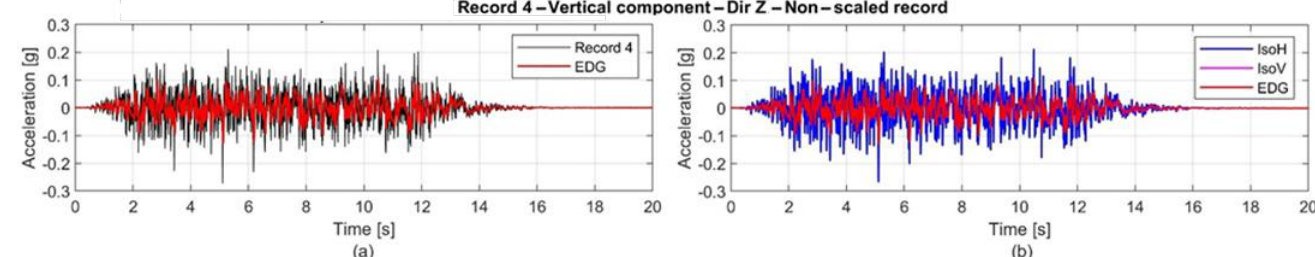
Figure 5. Vertical acceleration time history results for non-scaled Record 4—direction “Z”. ( a ) Record and EDG response comparison; ( b ) System response by isolation level. The horizontal acceleration time histories in the “X” direction are shown in Figure